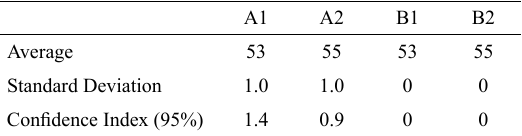
Figure 7. Statistical analysis of the independent variable effects on studied structural parameters Table 5. Brinell hardness